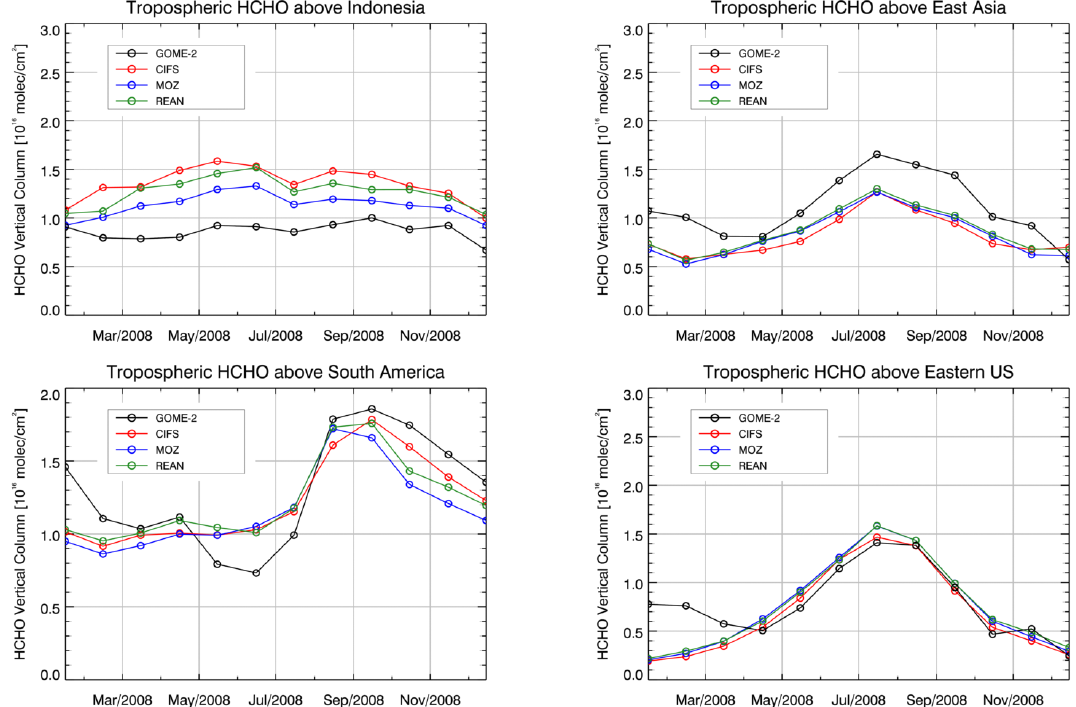
Figure 15. Time series of area-averaged tropospheric HCHO columns (10 16 moleccm − 2 ) from GOME-2 compared to model results of C-IFS, MOZ and REAN for different